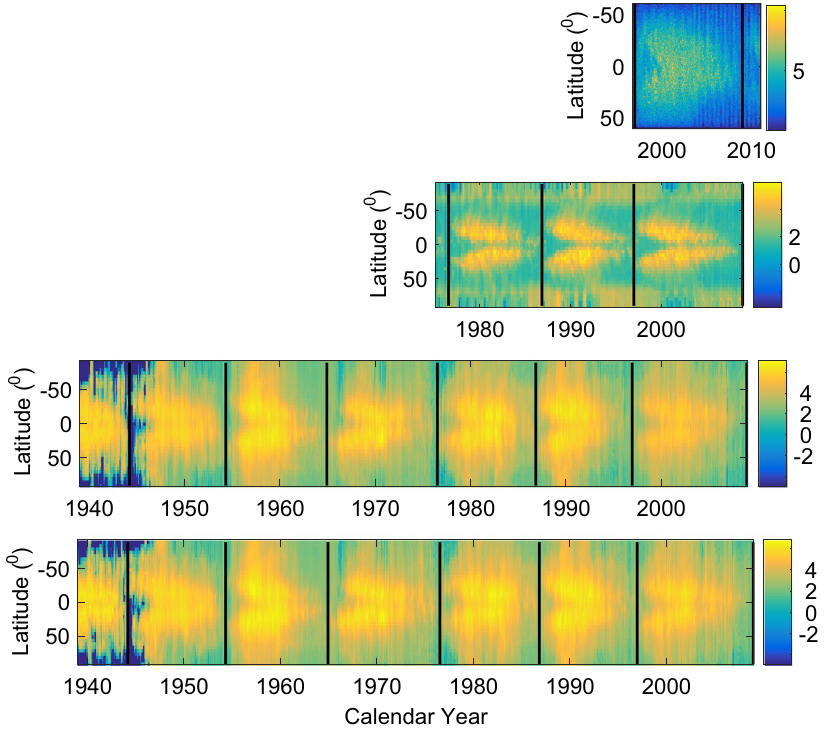
Figure 3. Time-latitude distribution of solar measurement quantities of four kinds. The first (top) panel: the small-scale magnetic elements (Component-II) whose fluxes span ( 4.27 − 38.01 ) × 10 solar magnetic field ( MF s ) from synoptic magnetographs. The third: CI measured at the east limb. And the fourth (bottom) panel: CI at the west limb. The vertical thick dashed lines show the minimum times of the solar